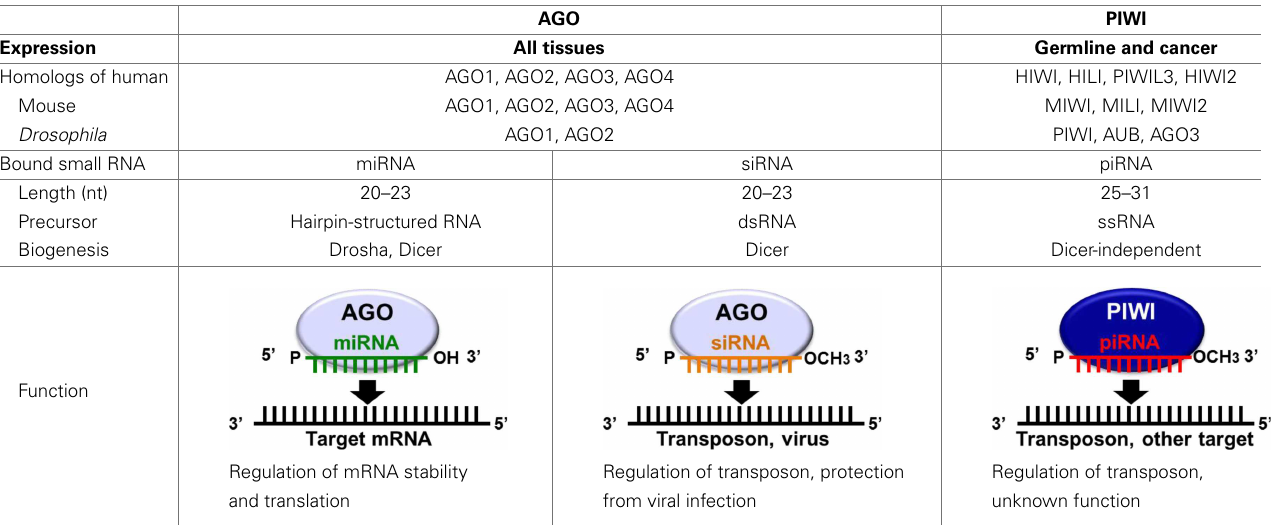
Table 1 |Argonaute family